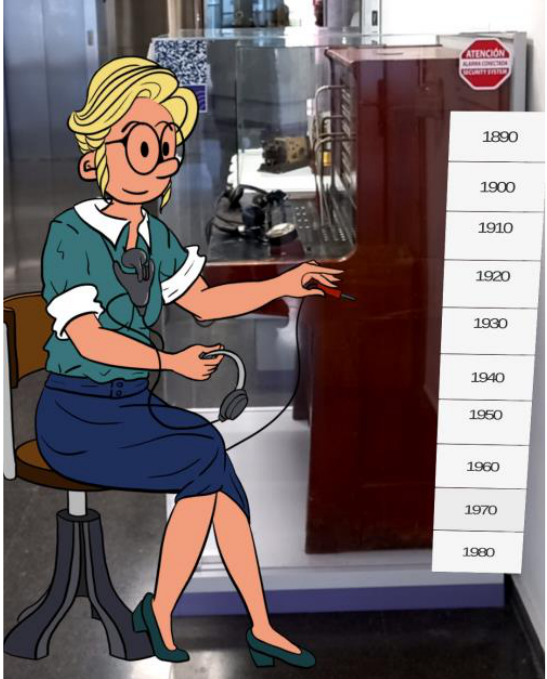
Figure 3. 1930s switchboard AR interactive content.